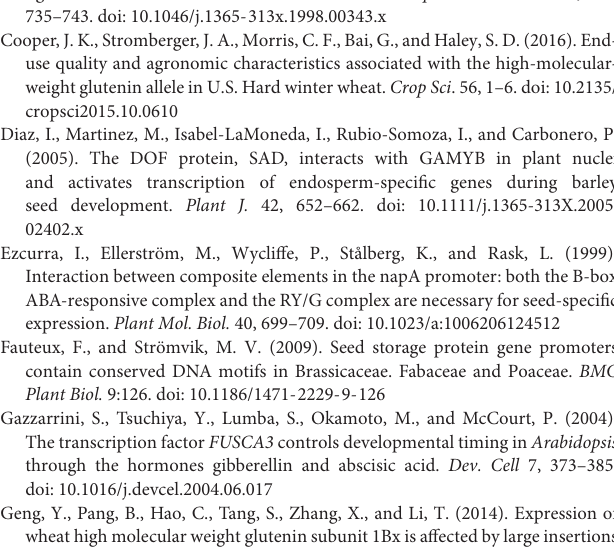
FIGURE S1 | The molecular identification by PCR for transgenic lines in A. thaliana . (A) The transgenic lines with GFP gene under the control of the At2S3 promoter and genetic background was wild type. WT: wild type. The primer used was GFP1 listed in the Supplementary Table S1. (B) The transgenic lines with GFP gene under the control of the At2S3 promoter and genetic background was AtFUSCA3 mutant line fus3-3 . MT: non-transgenic mutant type. The primer used was GFP1 listed in the Supplementary Table S1. (C) Transgenic lines with the GFP gene under the control of the At2S3 promoter and the TaFUSCA3 gene driven by the CaMV 35S promoter; the genetic background was the AtFUSCA3 mutant line fus3-3 . MT: non-transgenic mutant type. The primer used was GFP1 listed in the Supplementary Table S1. (D) Transgenic lines with the GFP gene under the control of the At2S3 promoter and the TaFUSCA3 gene driven by the CaMV 35S promoter; the genetic background was the AtFUSCA3 mutant line fus3-3 . MT: non-transgenic mutant type. The primer used was JDfusca3 listed in Supplementary Table S1. FIGURE S2 | The expression analyses of GFP and TaFUSCA3 by qRT-PCR in transgenic A. thaliana . The 14 DAP seeds were collected for the cDNA of qRT-PCR. (A) Relative expression levels of GFP in the transgenic lines with GFP gene; the genetic background was wild type. WT: wild type. (B) Relative expression levels of GFP in the transgenic lines with GFP gene; the genetic background were AtFUSCA3 mutant line fus3-3 . MT: non-transgenic mutant type. (C) Relative expression levels of GFP in the transgenic lines with GFP and TaFUSCA3; the genetic background were AtFUSCA3 mutant line fus3-3 . MT: non-transgenic mutant type. (D) Relative expression levels of TaFUSCA3 in the transgenic lines with GFP and TaFUSCA3; the genetic background was the AtFUSCA3 mutant line fus3-3 . MT: non-transgenic mutant type. Data are means ± SD ( n = 3). Three independent experiments were